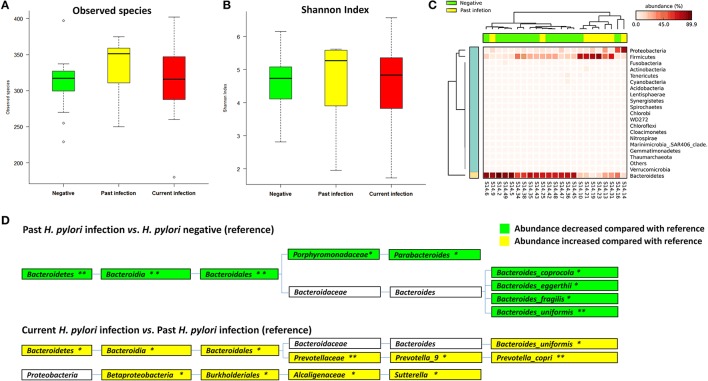
Associations between Helicobacter pylori infection and fecal microbiota. (A) Boxplot of observed species in different H. pylori status groups. The boxes indicate interquartile ranges (IQRs) and the median (blank line).Whiskers extend to the most extreme points within 1.5-fold IQR. Outliers are plotted individually (°). (B) Shannon index in different H. pylori status groups. (C) Heat-map of relative abundance distributions of the phyla in past H. pylori infection (n = 8) and negative groups (n = 15). (D) Cladogram of differently distributed taxa between groups. The differential taxa are illustrated between past H. pylori infection and negative groups, or current H. pylori infection and past infection groups as *p < 0.05 and **p < 0.01, respectively.